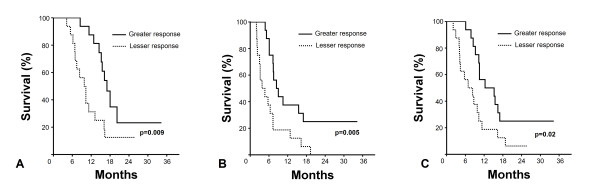
Comparative survival analyses between patients with greater and lesser PET-CT response. A: Overall survival (OS); B: Progression-free Survival (PFS); C: Local Regional Progression-free Survival (LRPFS). Solid line: greater SUVmax change; Dashed line: lesser SUVmax change.